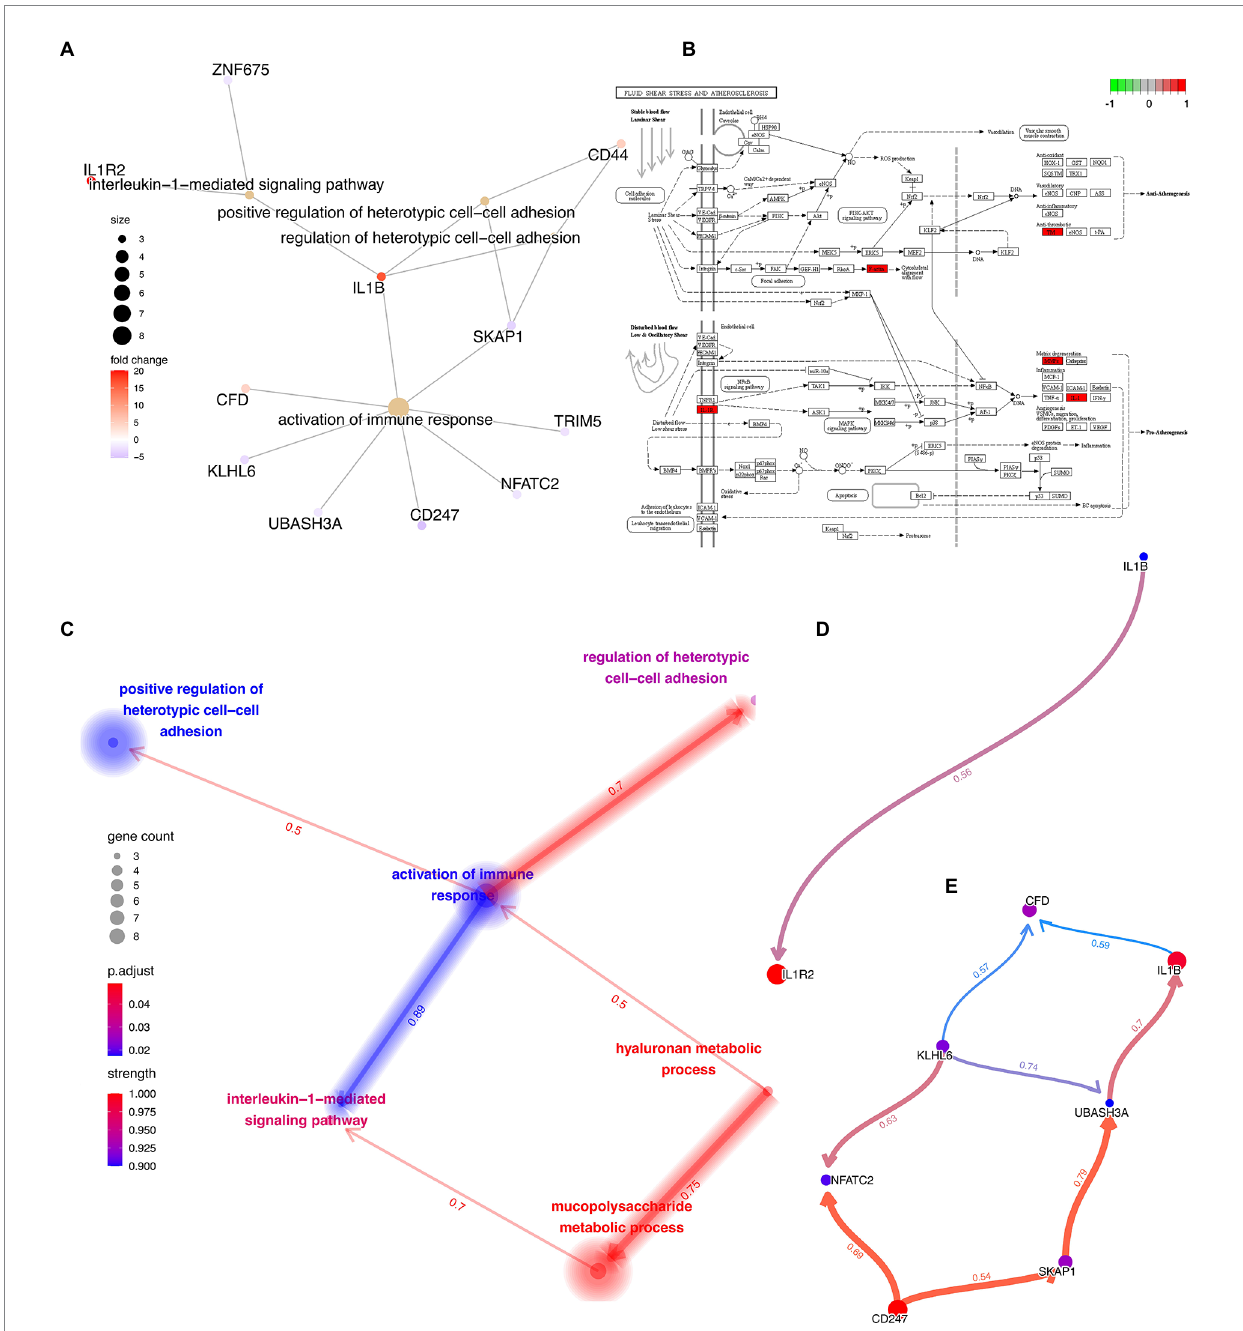
FIGURE 5 Functional Enrichment Analysis and Causal Relationship Inferring. (A) Interactive network demonstrating the interactions between the feature genes and the enriched GO terms and KEGG pathways. (B) Detailed KEGG pathway, “Fluid shear stress and atherosclerosis,” activated genes are marked in red. (C) Interactive network demonstrating the interactions between the different GO terms and KEGG pathways with directions. The directions of the arrows indicate the causal relationship. (D,E) Complex causal relationship inferred within the enriched GO terms, “activation of immune response” and “interleukin-1-mediated signaling